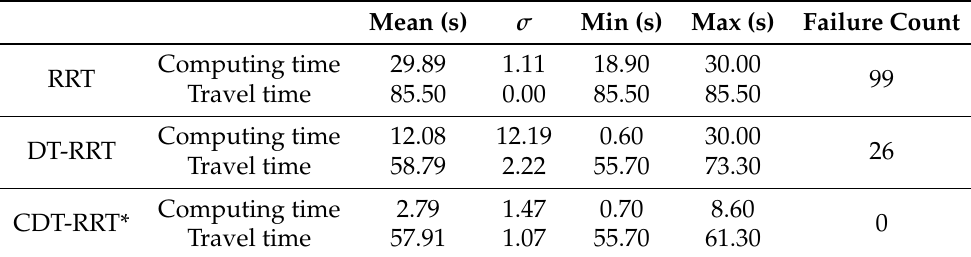
Figure 8. Histogram of the computing time for the results from simulation 3. Table 4. Summary of Planning Results from simulation 3.